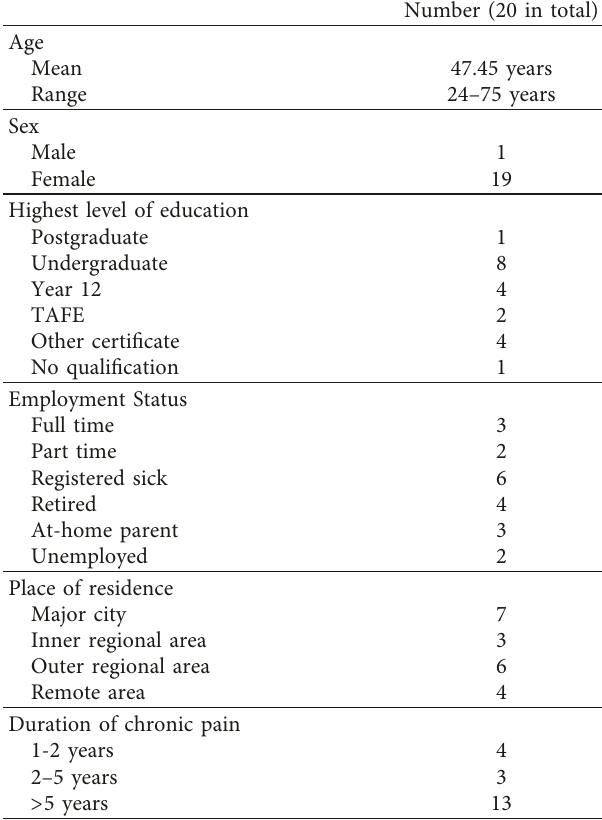
Table 1: Participant demographic and pain